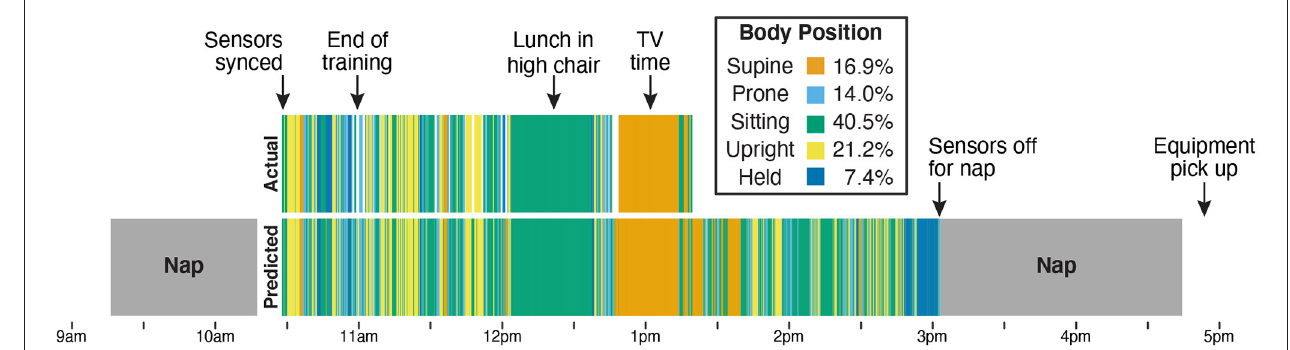
FIGURE 7 | Timeline from Participant B’s entire data collection showing actual position codes (top row) compared with model predictions of body position (bottom row). The legend indicates the bar color for each body position and lists the model’s prediction of how much time the infant spent in each position over the 4.5-h session. The sensors were placed on the infant after the first nap (at 10:30 a.m.). From 10:30 a.m. to 11:00 a.m., the infant and caregiver were guided through the scripted activities over the phone by the experimenter and completed the prescribed free play in front of the camera. Data from those 30 min were used to train the machine learning classifier. The remaining period (11 a.m. until the camera stopped at 1:15 p.m.) was used for validation. The video recording allowed us to verify that the 40-min period of sitting (from approximately 12 p.m. to 12:40 p.m.) corresponded to a meal with the infant sitting in a high chair and that the period of supine (from approximately 12:45 p.m. to 1:15 p.m.) corresponded to a period of TV viewing while the infant reclined in a seating device. The infant continued to wear the sensors until a nap at 3 p.m., which was the last recorded time before the experimenter picked up the equipment at 5